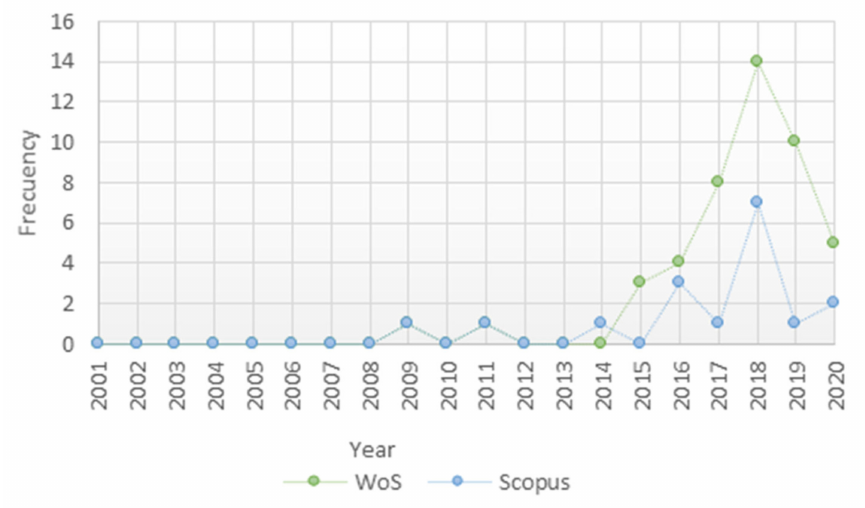
Figure 4. Evolution of the number of articles collected on “Magic Towns” in WoS and Scopus. Source: Own elaboration.